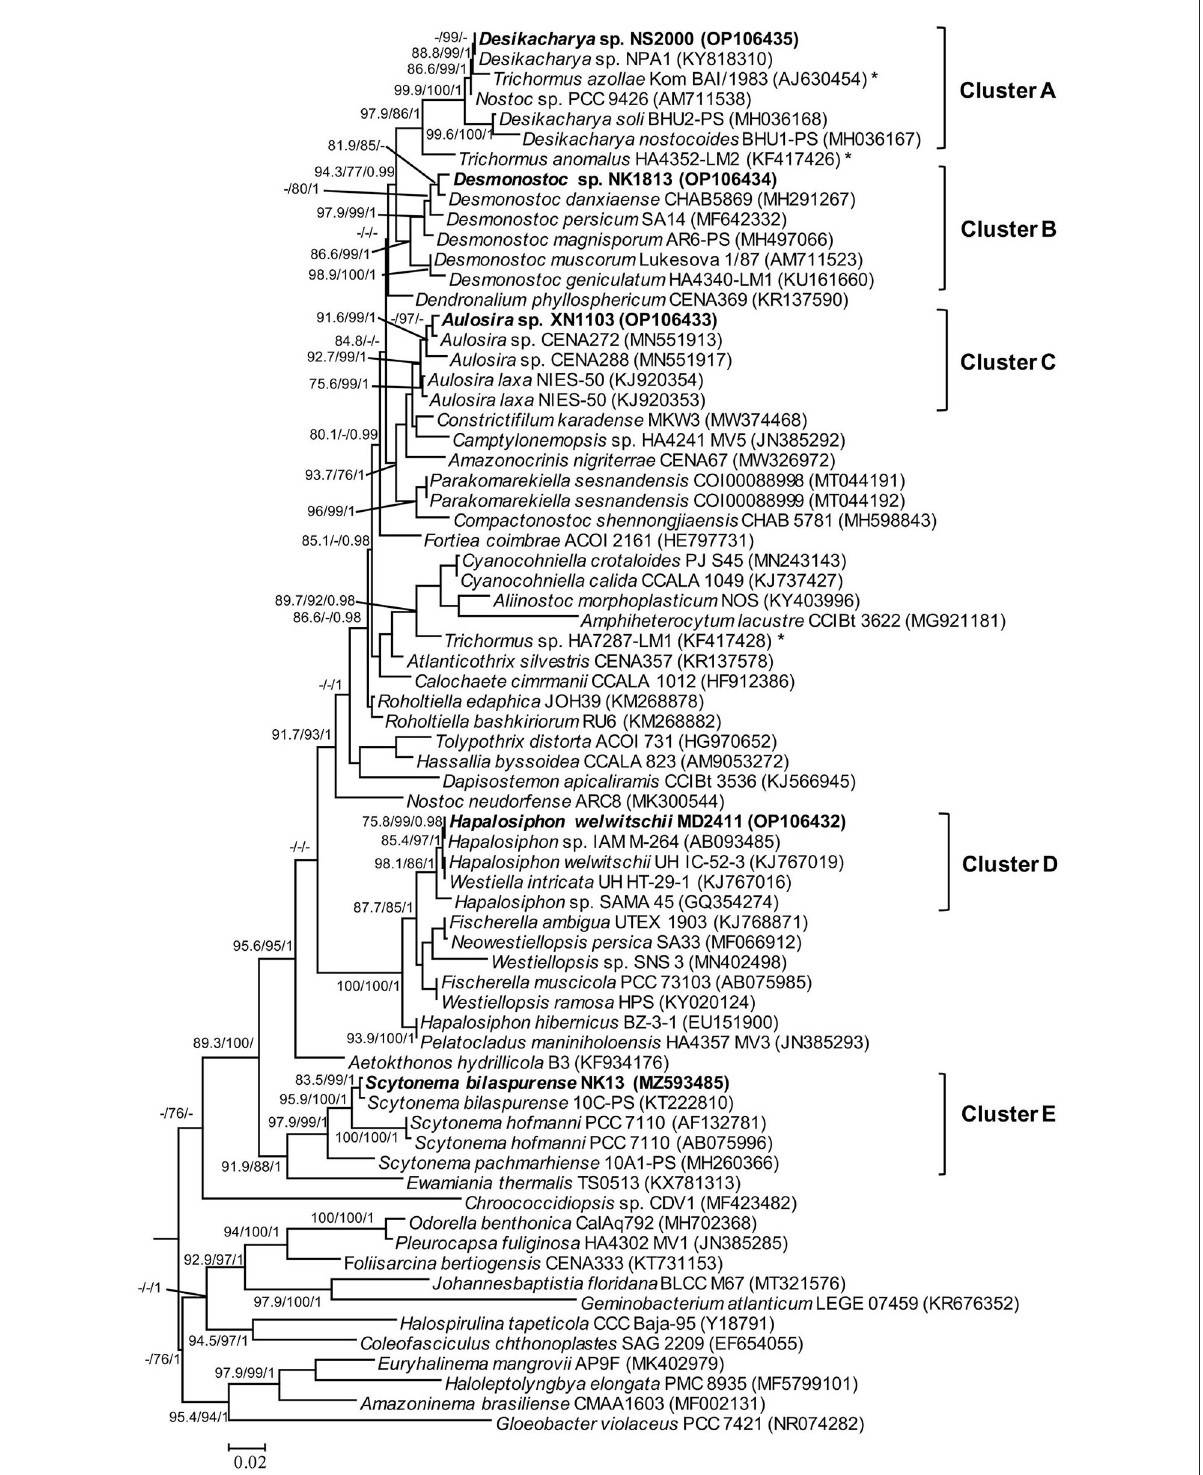
FIGURE2 Phylogram derived from maximum likelihood (ML) analyses of 16S rRNA sequence dataset. The analyses were conducted for 10 independent runs using MrBayes v3.2.5, and each run was carried out for 5 million generations by applying the GRT + G + I substitution model. The likelihood ratio test (SH-aLRT) (%) and ultrafast bootstrap support (BS) (%) values of IQTREE > 75% and Bayesian posterior probabilities (BPP) > 0.95 are indicated at nodes as SH-aLRT/BS/BPP. Scale bar indicates estimated substitutions per site; *: marks for the position of the Trichormus strain showing a polyphyletic